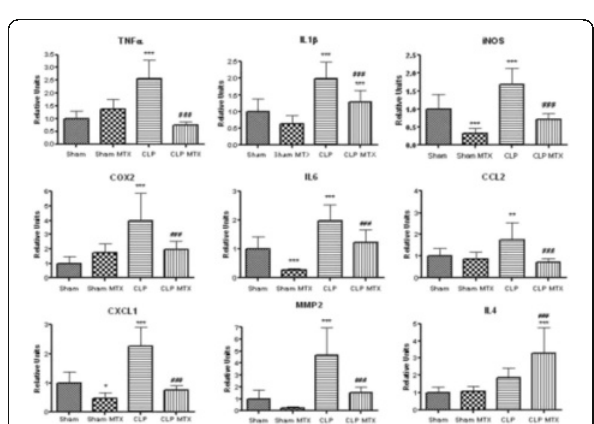
Fig. 55 (abstract A138). Relative expression of molecular markers in lung tissue homogenate corrected with GADPH as a control gen;calculated with RT-qPCR. All values are represented as mean ±SEM. *p<0.05 vs Sham and #p<0.05 vs CLP. **/## p<0.01, ***/### p<0.001 (Sham and Tham MTX n=13, CLP and CLP MTX